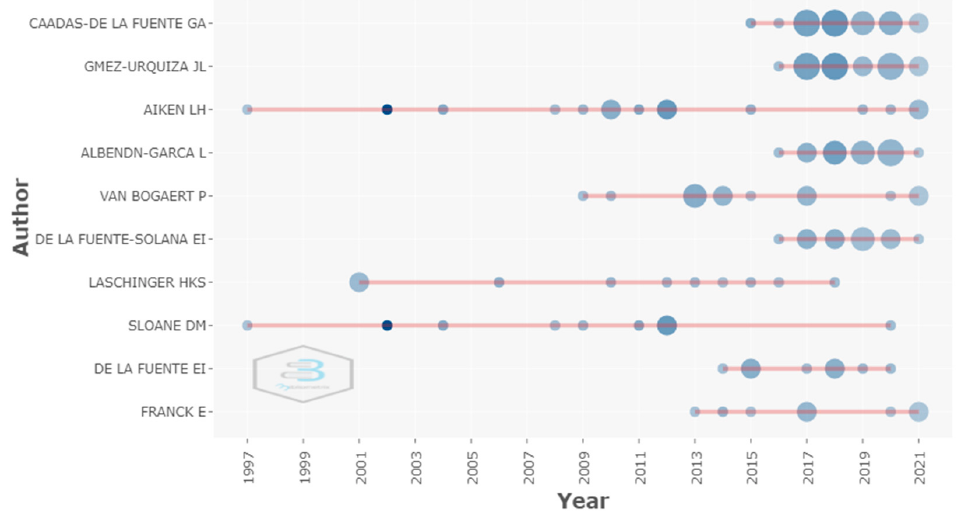
Figure 4. Top authors’ production over